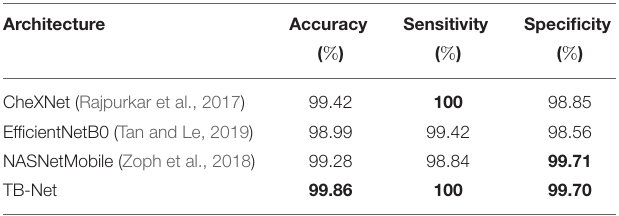
TABLE 1 | Accuracy, sensitivity, and specificity of TB-Net on the test data from the multi-national patient cohort. Architecture